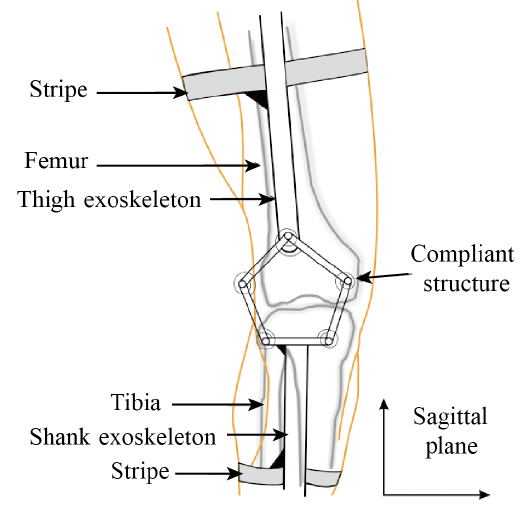
Figure 2. Model of five-bar